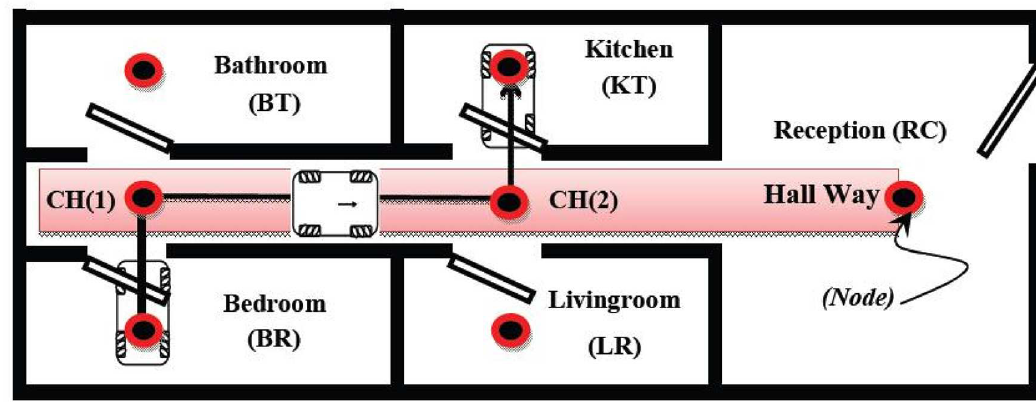
Fig 3. The apartment node map.